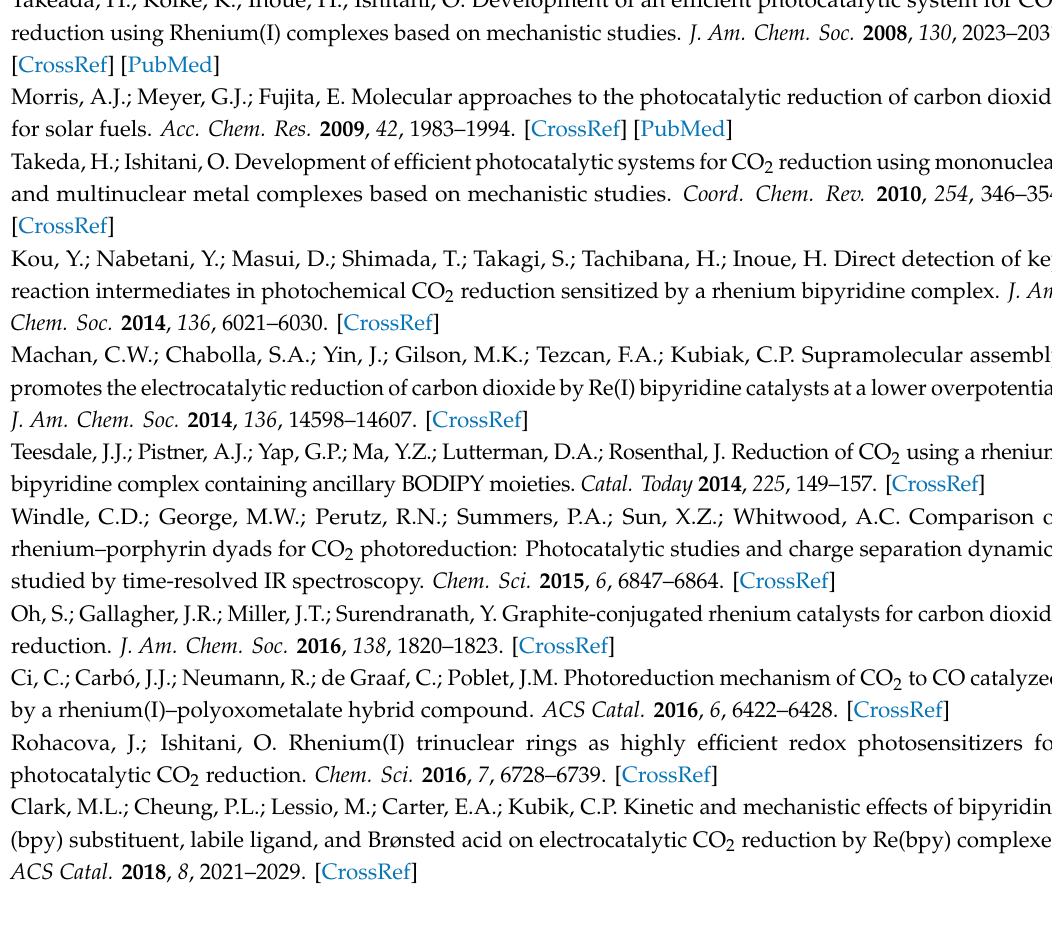
Supplementary Materials: The following are available online, Explanation about the d 6 electron configuration on these Re complexes, Computational Chemistry Details, Figures S1–S15: B3LYP optimized geometries of the species involved in the reaction between [ReY(CO) 3 (bipy)] (Y = NH 2 , NHMe, OPh, PH 2 , PHMe, PMe 2 , PHPh, PMePh, SH, SMe, SPh, NH p Tol, OH, OMe, and PPh 2 ) towards HMAD, Tables S1–S45: B3LYP and DLPNO-CCSD(T) absolute and relative energies and entropies as well as Cartesian coordinates of the key species implied in the reaction of [ReY(CO) 3 (bipy)] (Y = NH 2 , NHMe, OPh, PH 2 , PHMe, PMe 2 , PHPh, PMePh, SH, SMe, SPh, NH p Tol, OH, OMe, and PPh 2 ) towards HMAD, Figure S16: Pictures of the HOMO of the reactant complexes [ReY(CO) 3 (bipy)] (Y = PHMe, PPh 2 , PMePh), Table S46: Variation of the DLPNO-CCSD(T) relative Gibbs energies for all the analogous species when going from NH 2 to NHMe and NH p Tol, Table S47: Variation of the DLPNO-CCSD(T) relative Gibbs energies for all the analogous species when going from OH to OMe and OPh, Table S48: Variation of the DLPNO-CCSD(T) relative Gibbs energies for all the analogous species when going from PH 2 to PHMe, PMe 2 , PHPh, PPh 2 , and PMePh, Table S49: Variation of the DLPNO-CCSD(T) relative Gibbs energies for all the analogous species when going from SH to SMe and SPh, Table S50: Variation of the DLPNO-CCSD(T) relative Gibbs energies for all the analogous species when going from NH 2 , NHMe, and NH p Tol to PH 2 , PHMe, and PHPh, respectively, Table S51: Variation of the DLPNO-CCSD(T) relative Gibbs energies for all the analogous species when going from OH, OMe, and OPh to SH, SMe, and SPh,